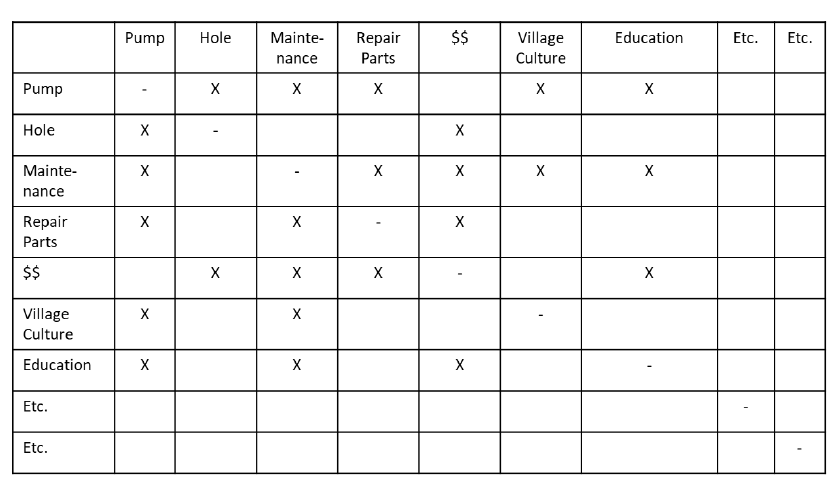
Fig. 30. System breakdown structure for Ayolé